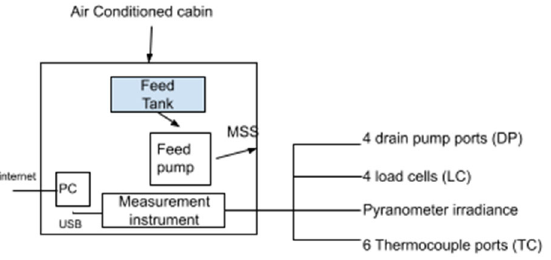
Figure 4. Assembled prototype in the KISR laboratory before commissioning.